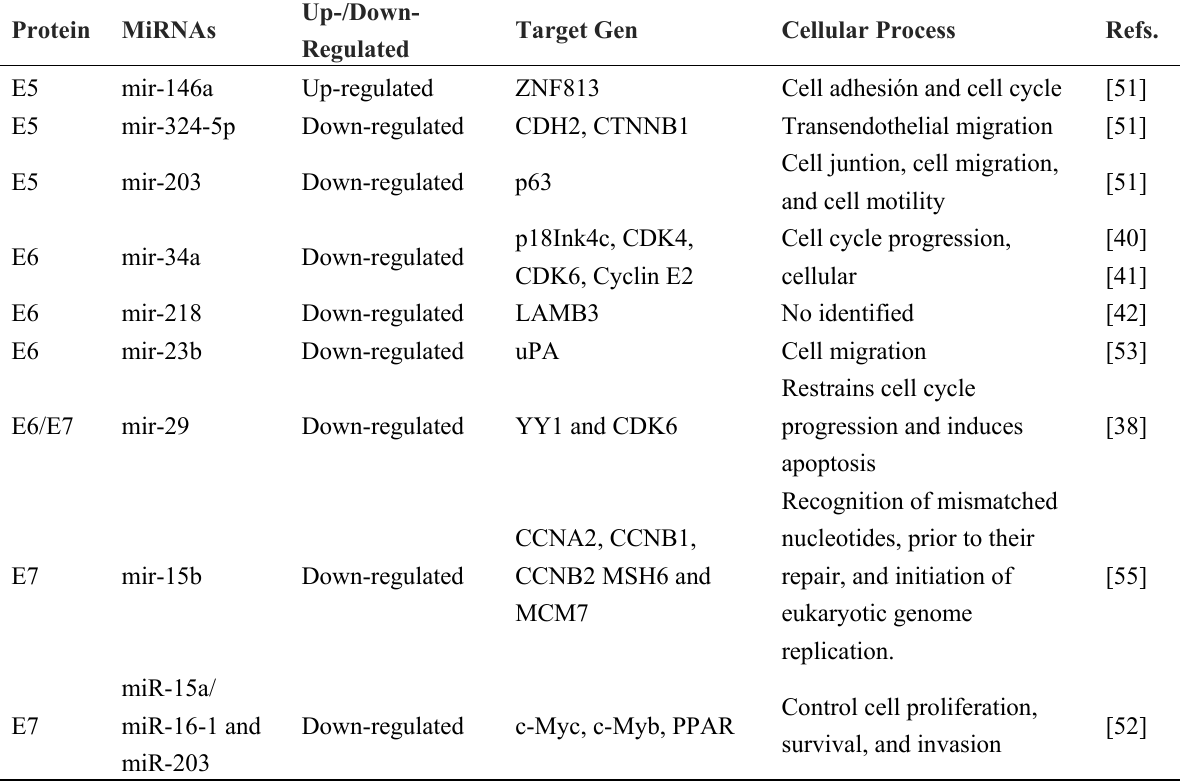
Table 2. HPV-Oncoproteins are able to regulate the expression of